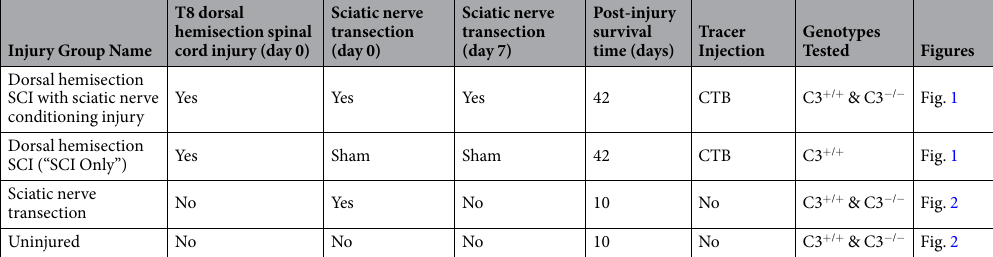
Table 1. Summary of Groups and Methods for In Vivo Axon Regeneration and Neuronal Survival Experiments. Injury group names listed here are used throughout the text, alongside genotype, to describe each experimental